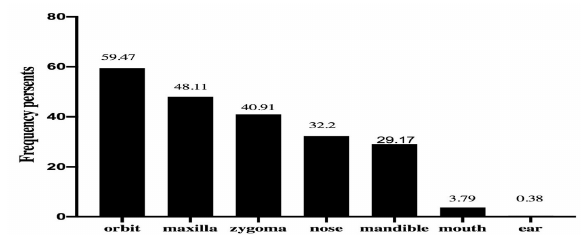
Figure 1. Type of maxillofacial injuries.